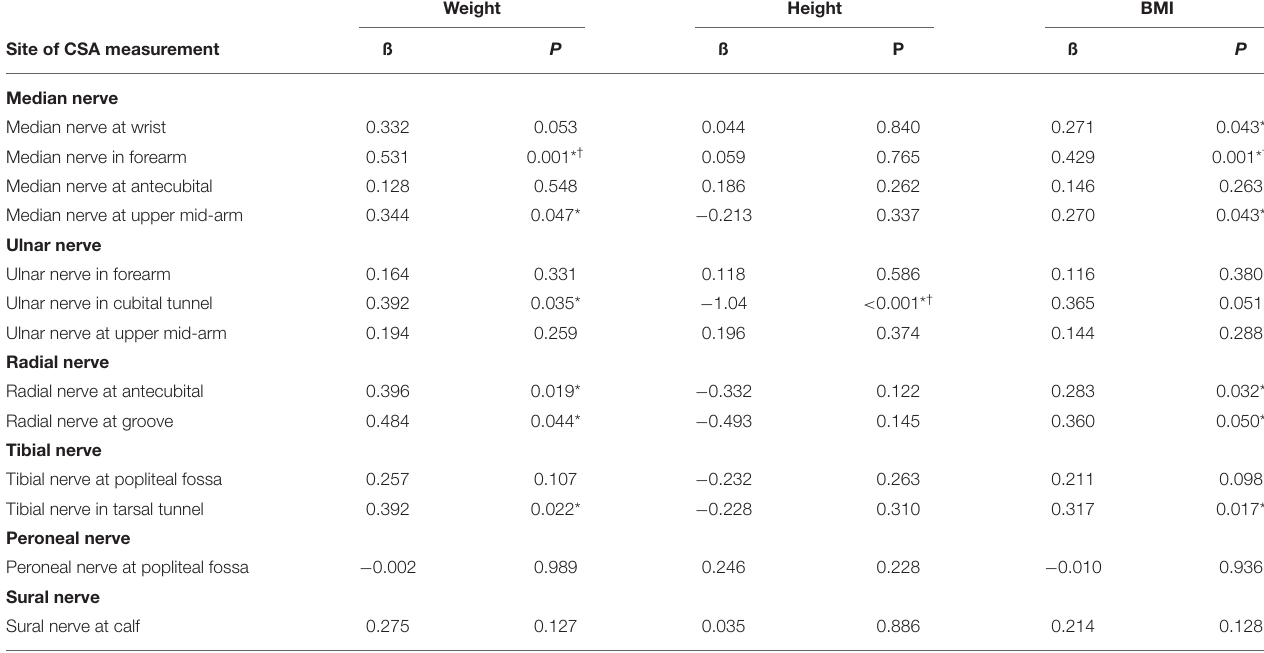
TABLE 4 | Multivariant analysis of CSA values with respect to height and weight. Weight